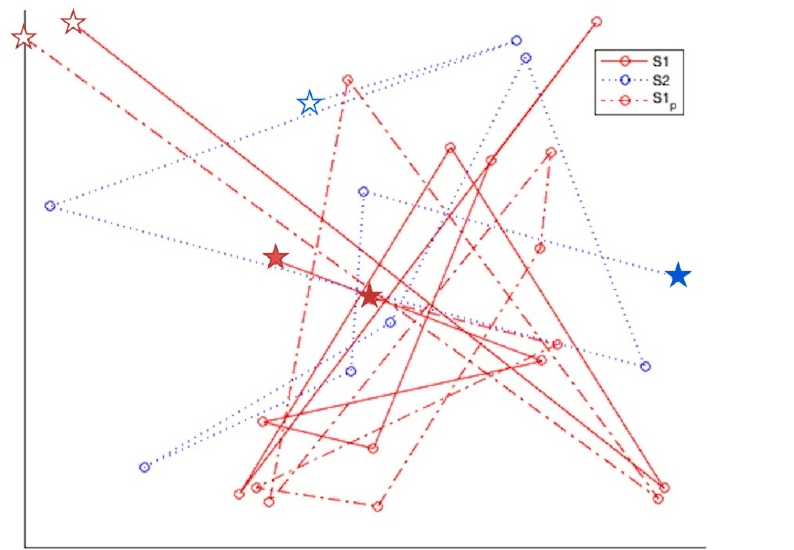
Figure 9. Examples of random scanpaths S1 and S2 illustrating high variability. S1p is shown as a duplicate of S1 perturbed with σ = 0.1 W . This experiment tests for higher similarity between S1 and S1p than with S2, given the increasing noise. Start and end fixation is represented with (cid:73) and (cid:72) ,